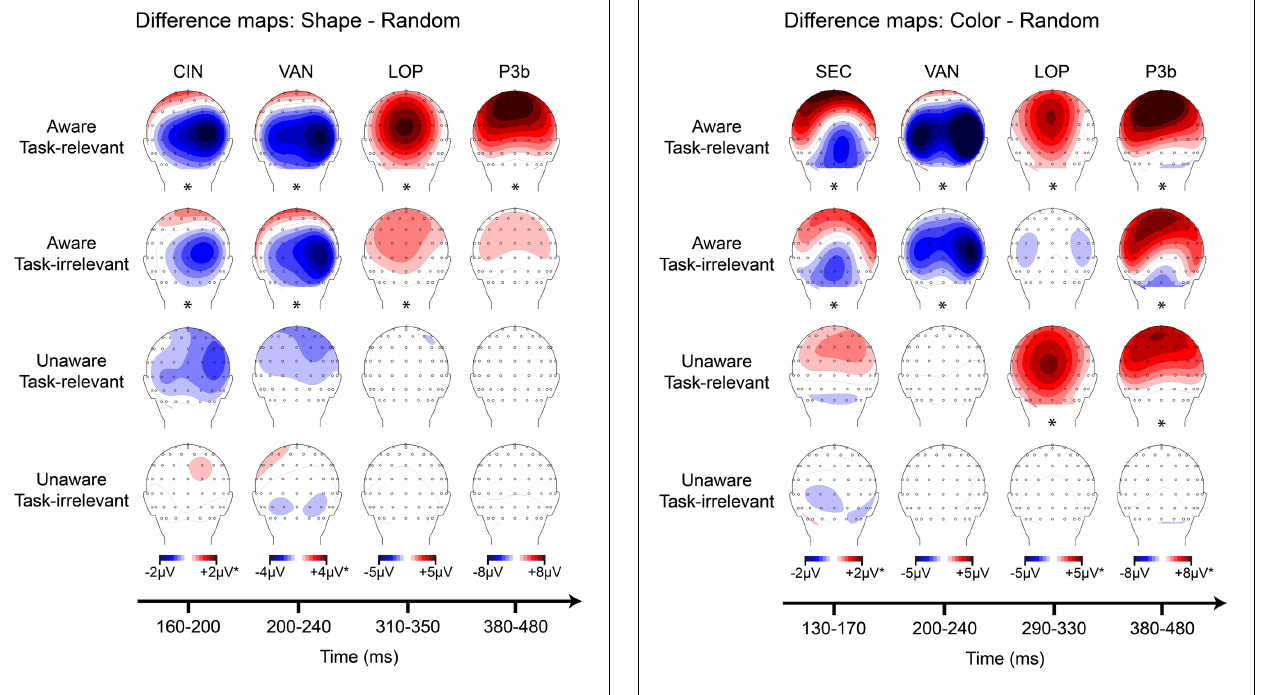
FIGURE 9 | Grand-averaged difference wave topographies (4-red-lines minus random) plotted over the posterior scalp for the four components of interest (columns) across the four main experimental conditions (rows). Note that the amplitude scales for the SEC and LOP components were adjusted to ± 1 µ V for the unaware conditions, and for the P3b component ± 2 µ V for all conditions except the aware, task-relevant condition. Asterisks indicate significant amplitude differences ( p < 0 . 05) between shape and random ERP as assessed via cluster mass permutation tests for each condition